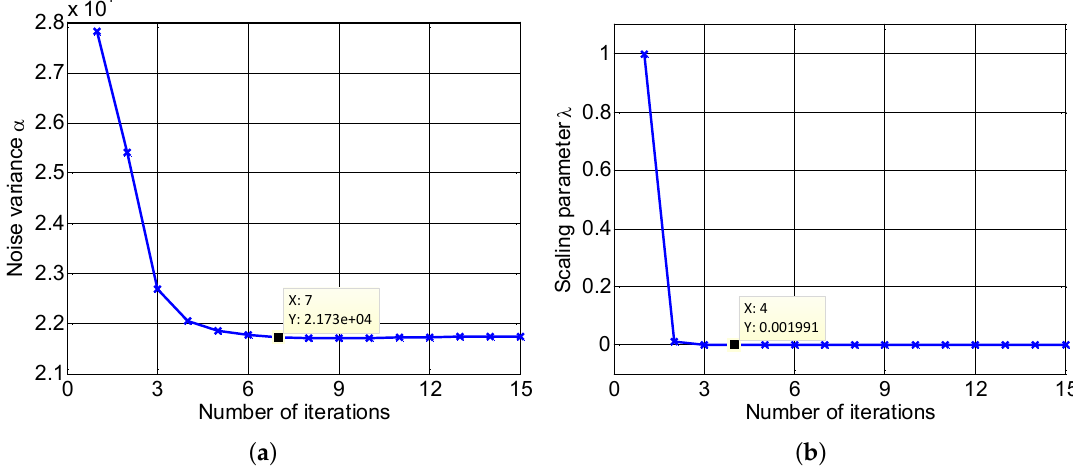
Figure 11. Update of model parameters: ( a ) noise variance α ; ( b ) scale parameter λ